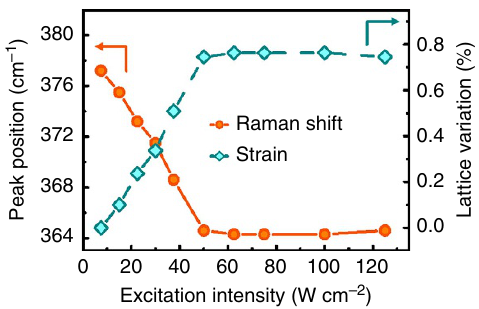
Figure 2 | Photon-induced strain measurement of SrRuO 3 /SrTiO 3 . The change in Raman frequency of the A g phonon modes and the in-plane lattice variations are shown as a function of excitation